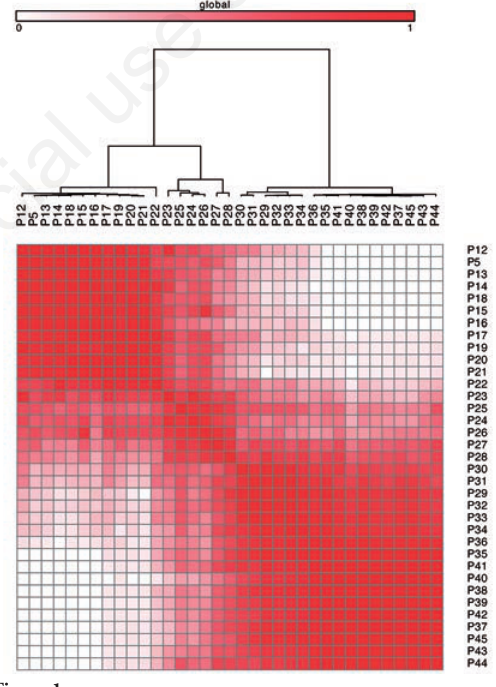
RISULTATI: L’espressione di 24 exo-miRnA viene modulata dalla chemioterapia, suggerendo il loro poten- ziale ruolo come marcatori della risposta